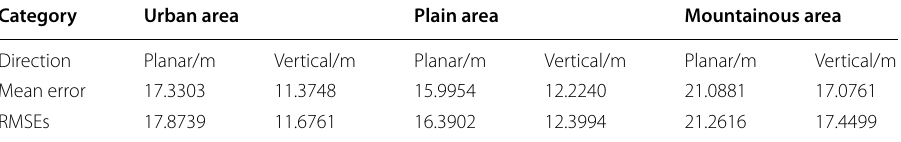
Table 3 Mean errors and RMSEs of the direct forward intersection, obtained using the vendor-provided RPCs, for three different